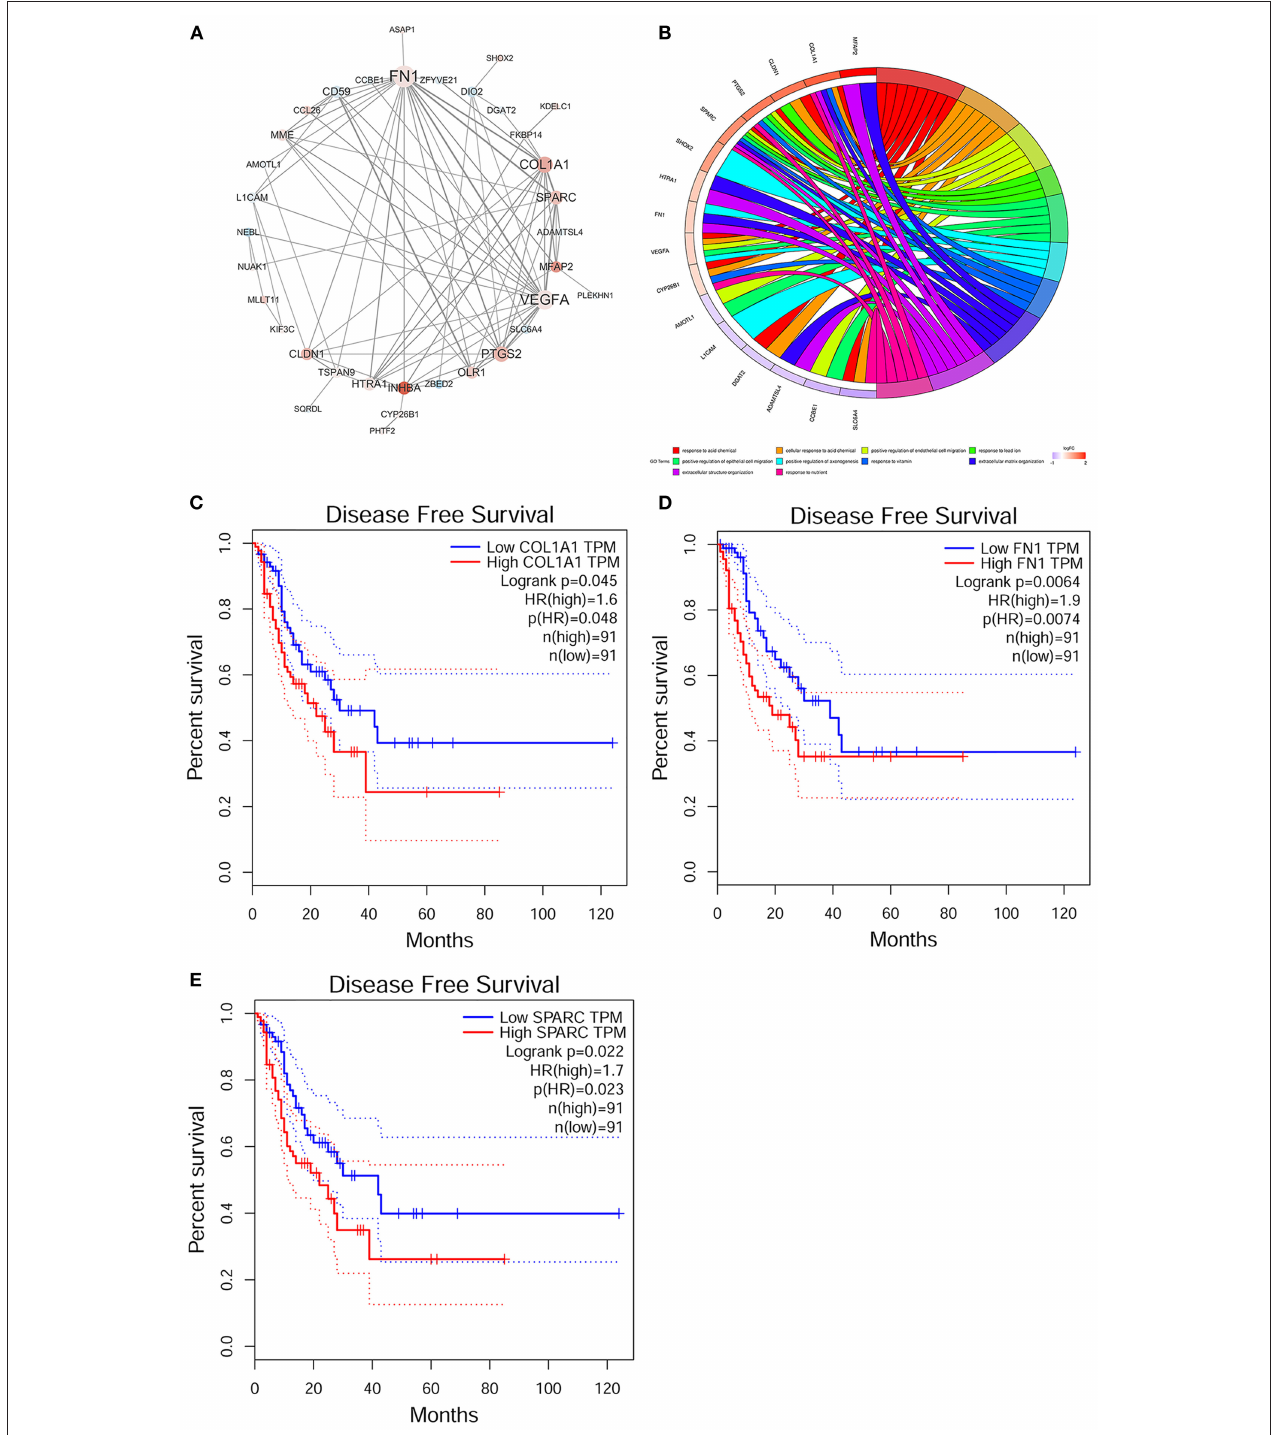
FIGURE 7 | Protein–protein interaction (PPI) network analysis and survival analysis of the paclitaxel resistance-specific and non-paclitaxel resistance-specific genes. (A) PPI network. Red points indicate paclitaxel resistance-specific genes and blue points indicate non-paclitaxel resistance-specific genes. The size of the node was determined by the degree of each node and the color depth of the node determined by the |log2FoldChange| of the gene. The thickness of the node connection depends on the combined scores between the nodes. (B) The top 10 Gene Ontology (GO) terms and corresponding genes in the PPI network were visualized in the chord diagram. (C–E) Disease-free survival analyses of COL1A1 (C) , FN1 (D) , and SPARC (E) based on The Cancer Genome Atlas Esophageal Carcinoma (TCGA-ESCA).